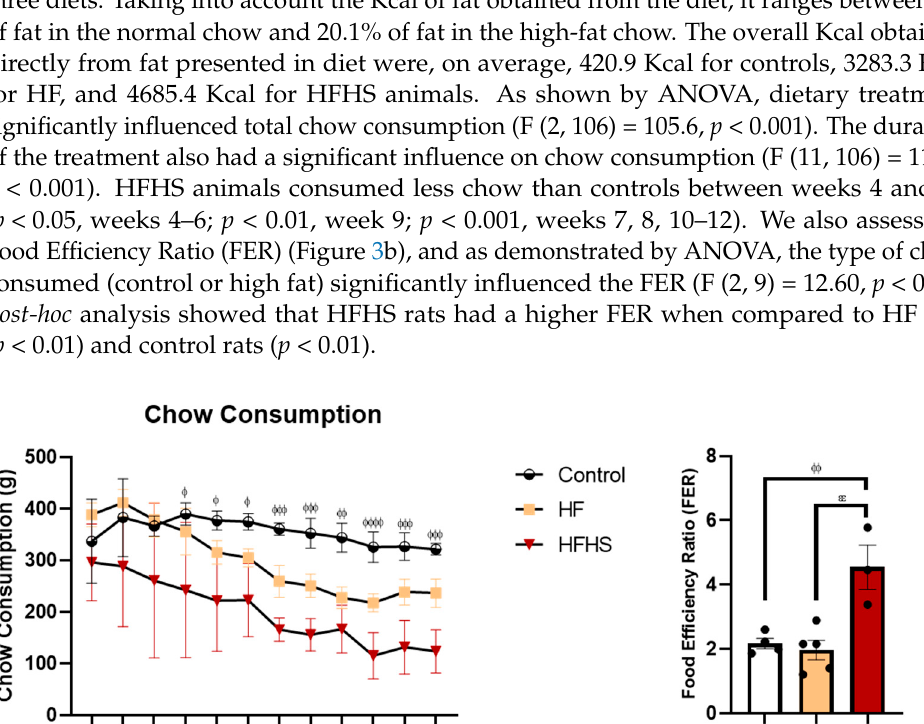
Figure 4. Graphical representation of liquid consumption during treatment. The control and HF groups consumed tap water, whereas the HFHS group consumed a 15% liquid sugar solution. Between weeks 1 and 12, HFHS animals consumed more liquid than the HF animals and controls.